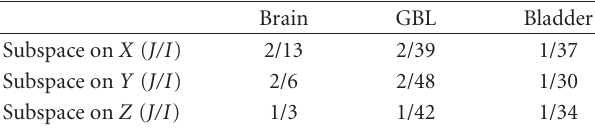
Figure 5: Resample with ray casting (a) original surface of kidney, (b) resampled surface of kidney.